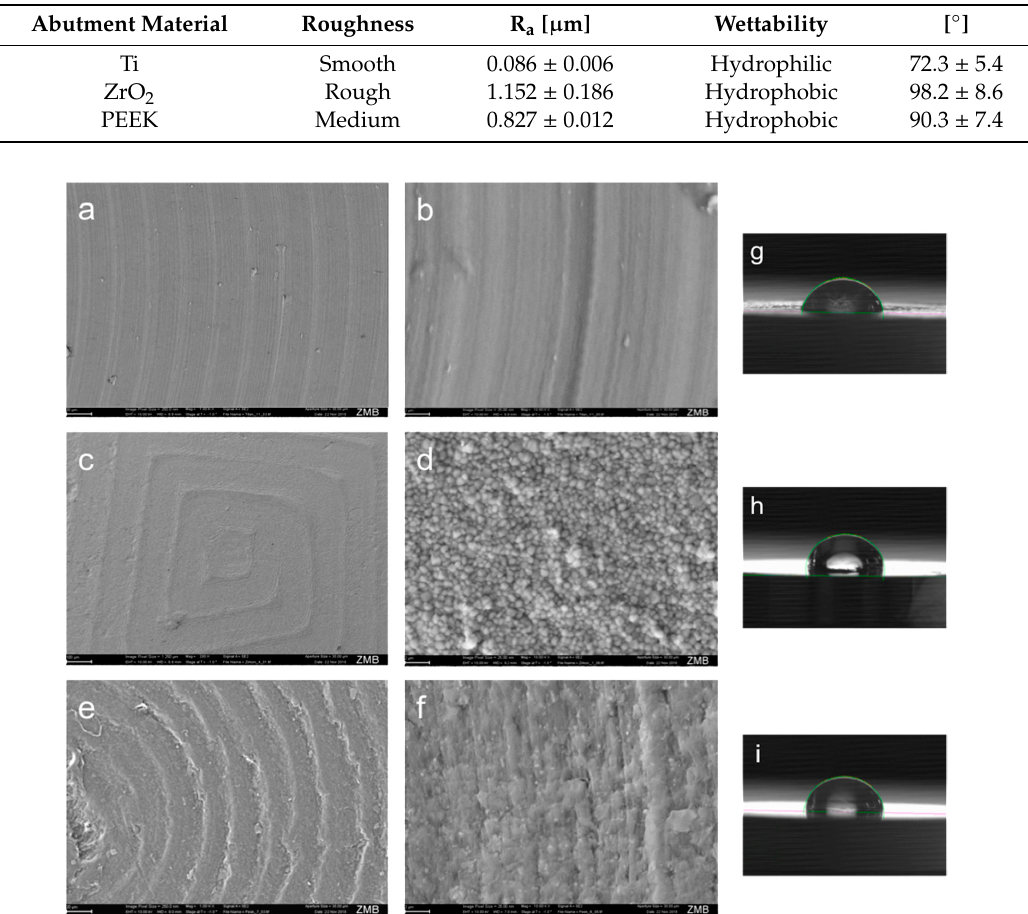
Figure 5. Microphotographs of surface topographies captured by scanning electron microscopy (SEM) at 1k× and 100k× magnification. a and b ) titanium, c and d ) zirconia, e and f ) PEEK. Contact at 1k × and 100k × magnification. ( a , b ) titanium, ( c , d ) zirconia, ( e , f ) PEEK. Contact angle of water angle of water droplet (1 μ l) on g) titanium, H, Zirconia and i ) PEEK. droplet (1 µ L) on ( g ) titanium, H, Zirconia and ( i )